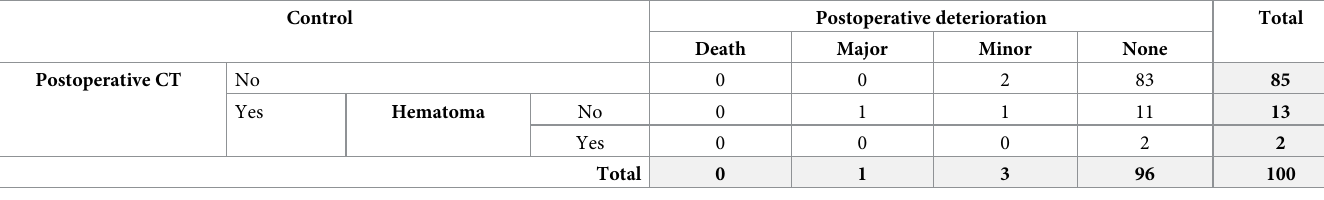
Table 4. Postoperative imaging, hematoma and neurologic status in the control cohort.